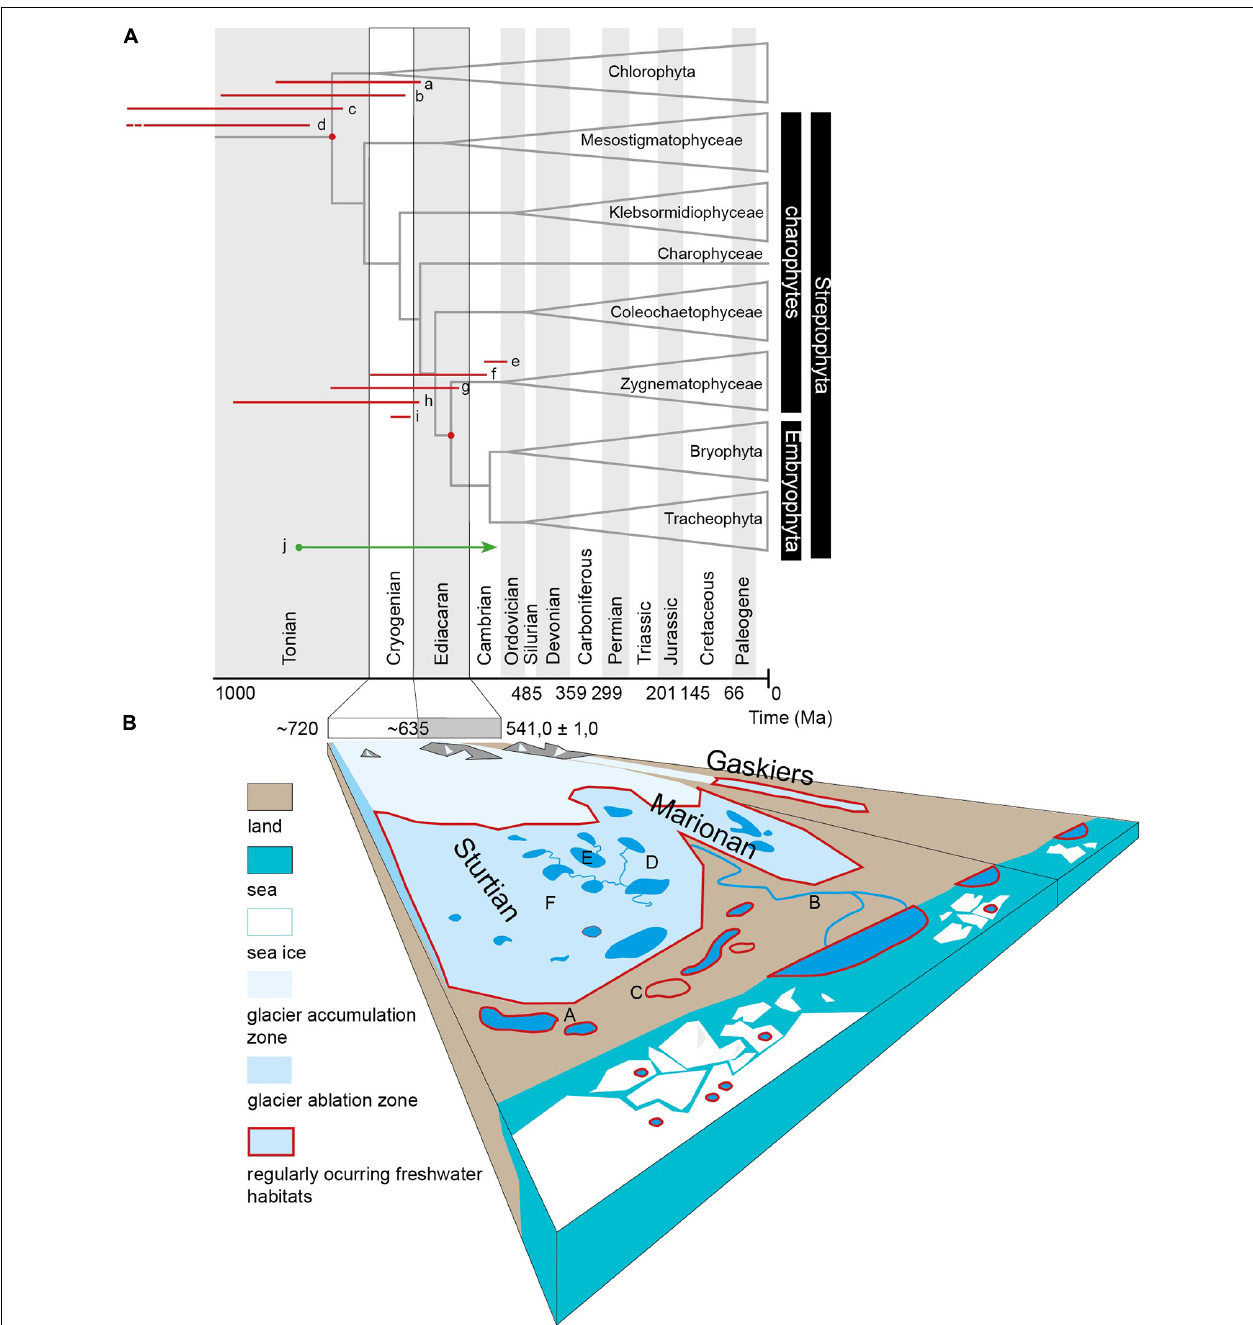
FIGURE 1 | (A) The phylogenetic tree with time estimates for the splits of Chlorophyta–Streptophyta and Zygnematophyceae–Embryophyta. Tree adapted from Morris et al. (2018b), projected over timescale based on international geostratigraphic chart (2020). The red lines at the respective node represent 95% highest posterior densities of estimates presented by Hedges et al. (2018), Morris et al. (2018b), Strassert et al. (2021), and Su et al. (2021): a–Streptophyta, Morris et al. (2018b) all calibrations, b–Streptophyta, Hedges et al. (2018) Mesozoic calibrations, c–Streptophyta, Hedges et al. (2018) Spermatophyta